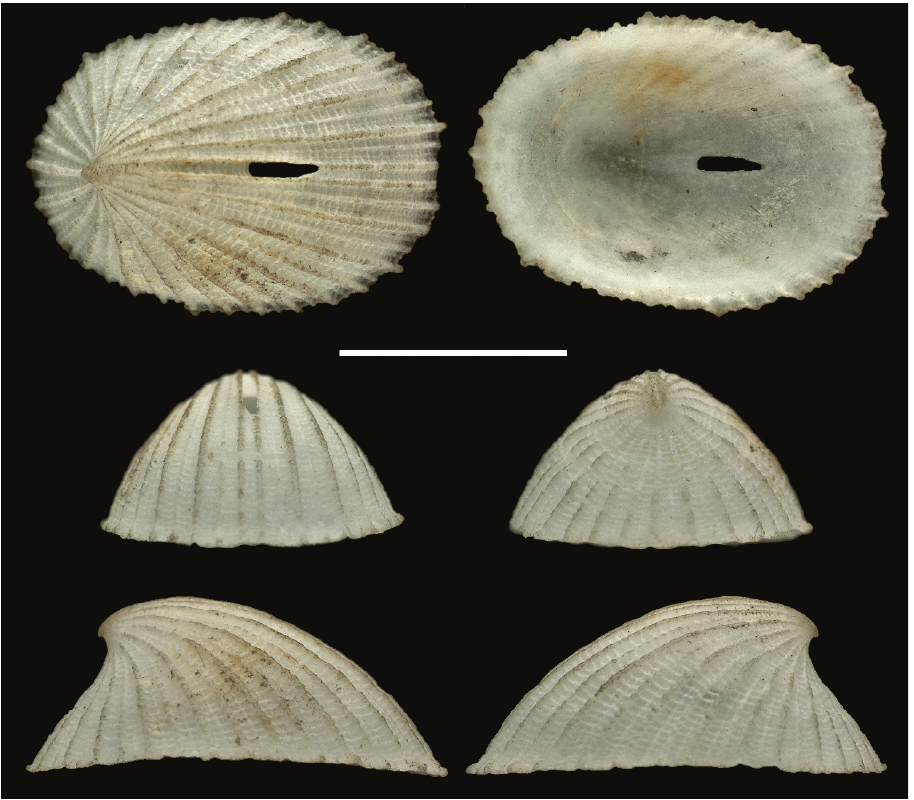
Figure 15. Rimula rhips Herbert & Kilburn, 1986. Holotype T3018/NMSA-MOL 0C1192. Scale bar: 5